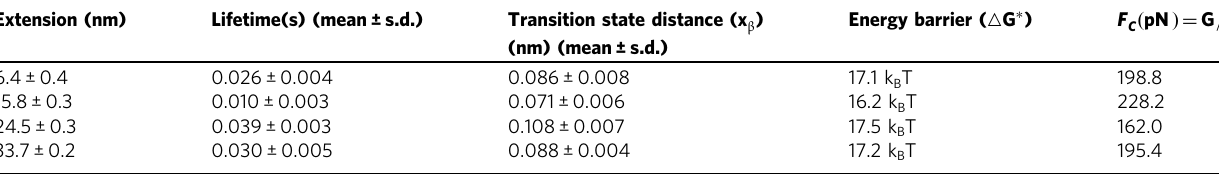
Table 2 The kinetic parameters of all unfolding steps of Cdh23 EC1-27 in HAP mode.